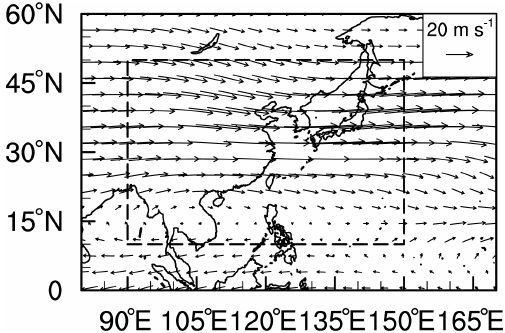
Figure 1. Horizontal coverage of our dataset overlapped with av- erage 500hPa winds, derived from ERA5 for April to June 2016– 2020. The black rectangle represents the coverage of the RC centers.